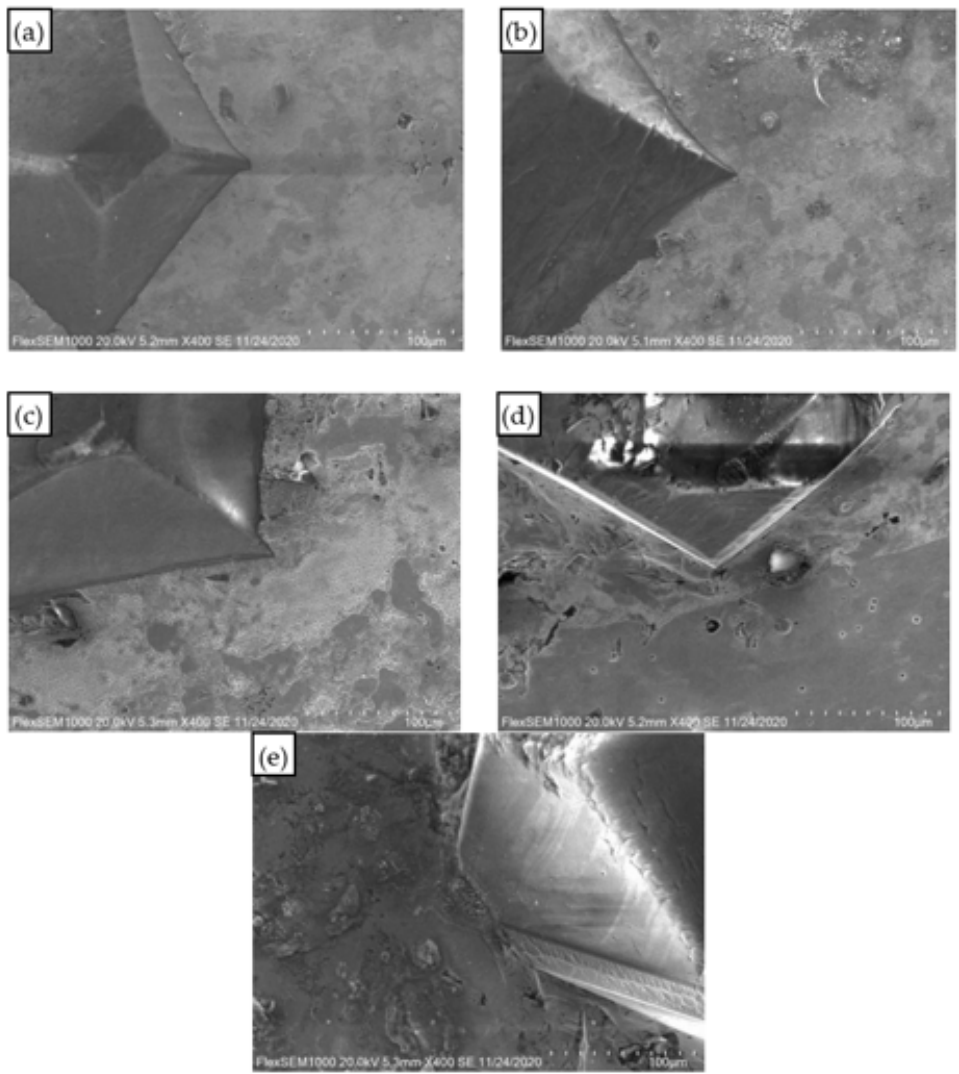
Figure 4. Bonding interface between diamond particles and copper matrix. ( a ) 740 °C; ( b ) 750 °C; ( c ) 760 °C; ( d ) 770 °C; ( e ) 780 °C.